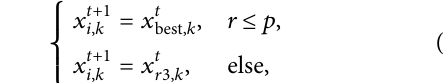
1 – F 4 . (a) F 1 . (b) F 2 . (c) F 3 . (d) F 4